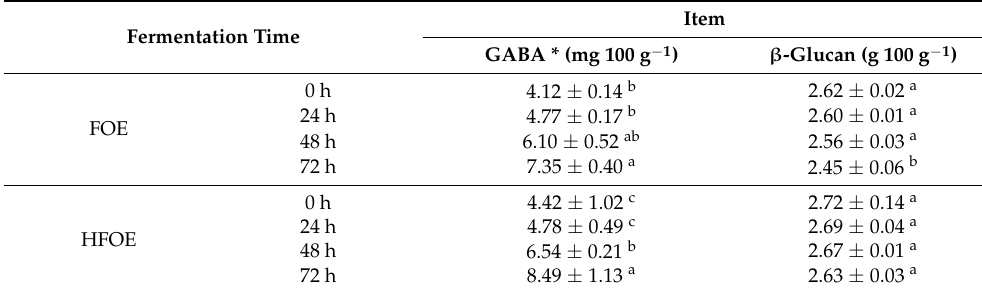
Table 3. The γ -aminobutyric acid and β -glucan content in FOE and HFOE during fermentation up to 72 h (mean ± SE), n = 8.